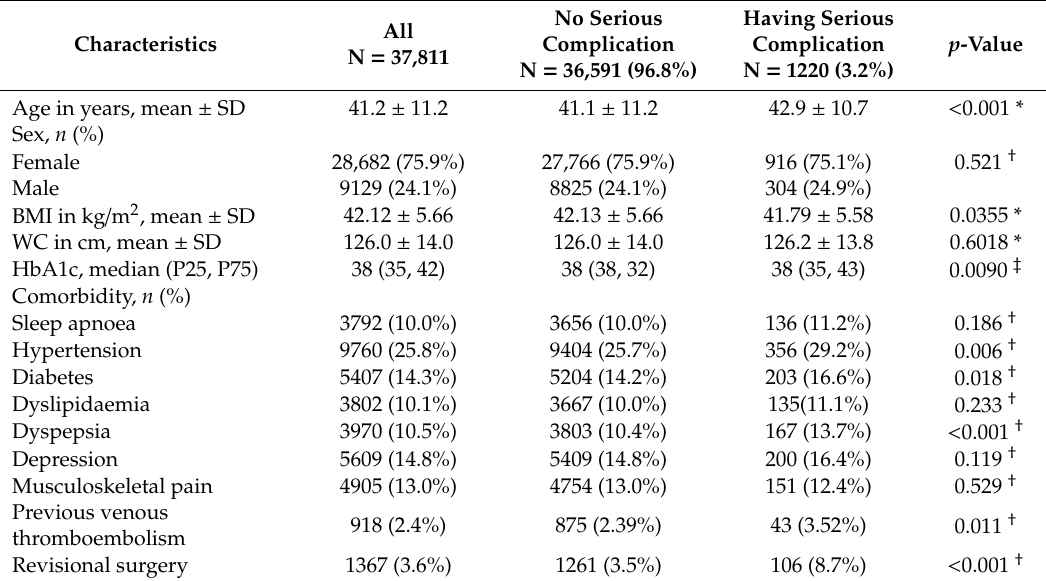
Table 1. Base line characteristics of the training patients.